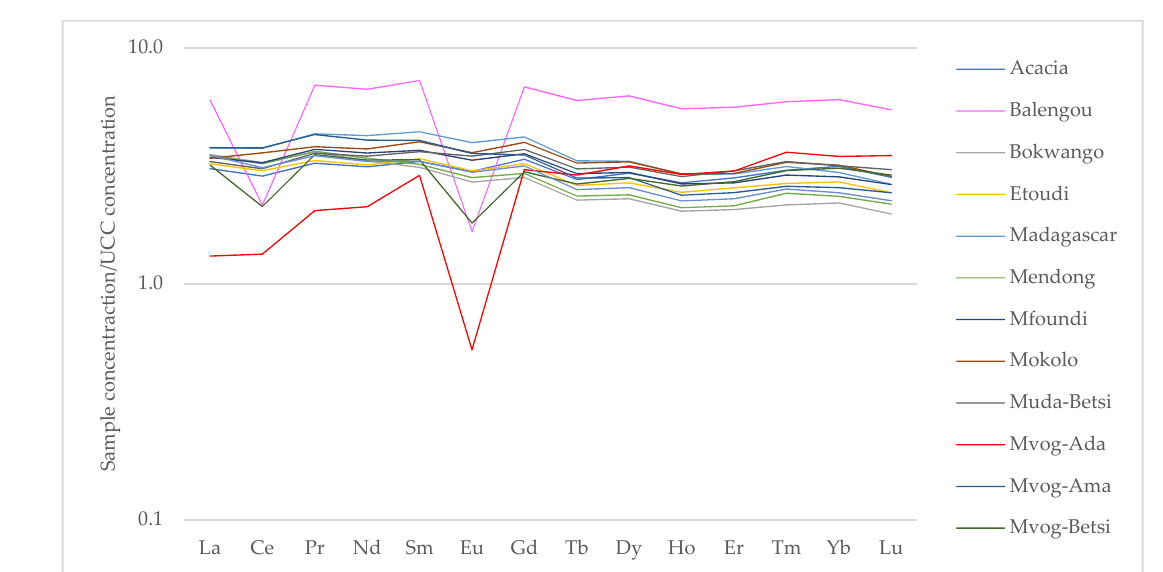
Figure 6. Spider diagrams showing upper continental crust (UCC)-normalised rare earth elements in the studied geophagic clays.